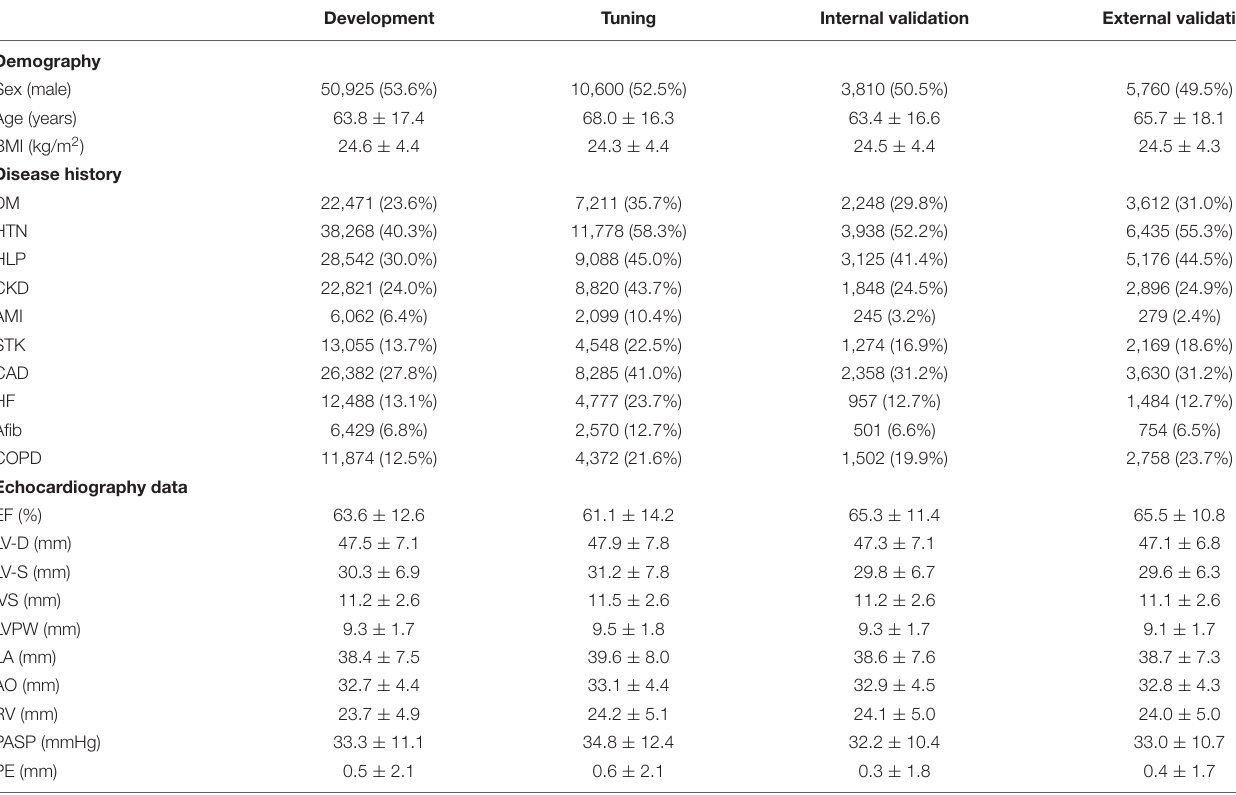
TABLE 1 | Baseline